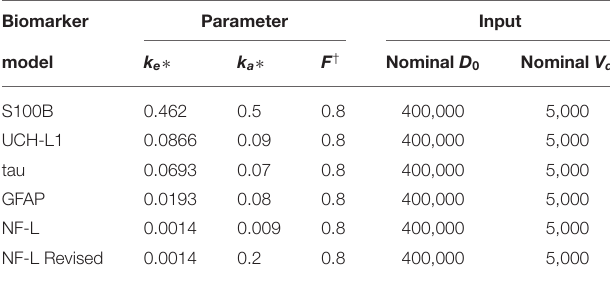
TABLE 2 | Kinetic models with calculated